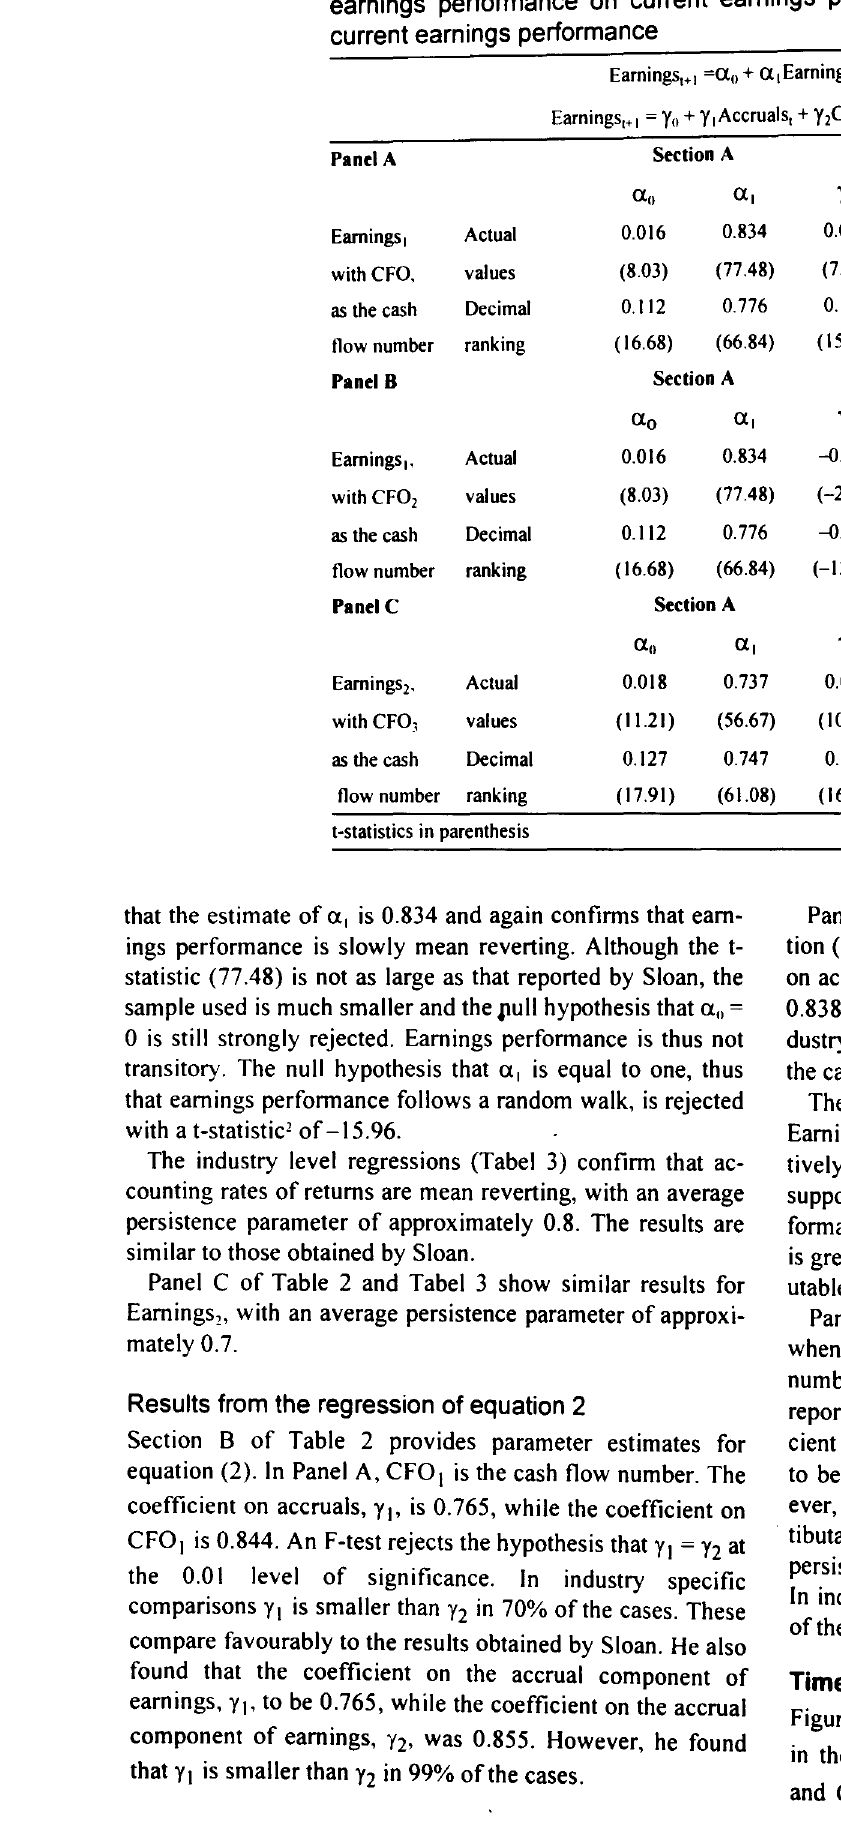
Table 2 Results of pooled ordinary least squares regressions of